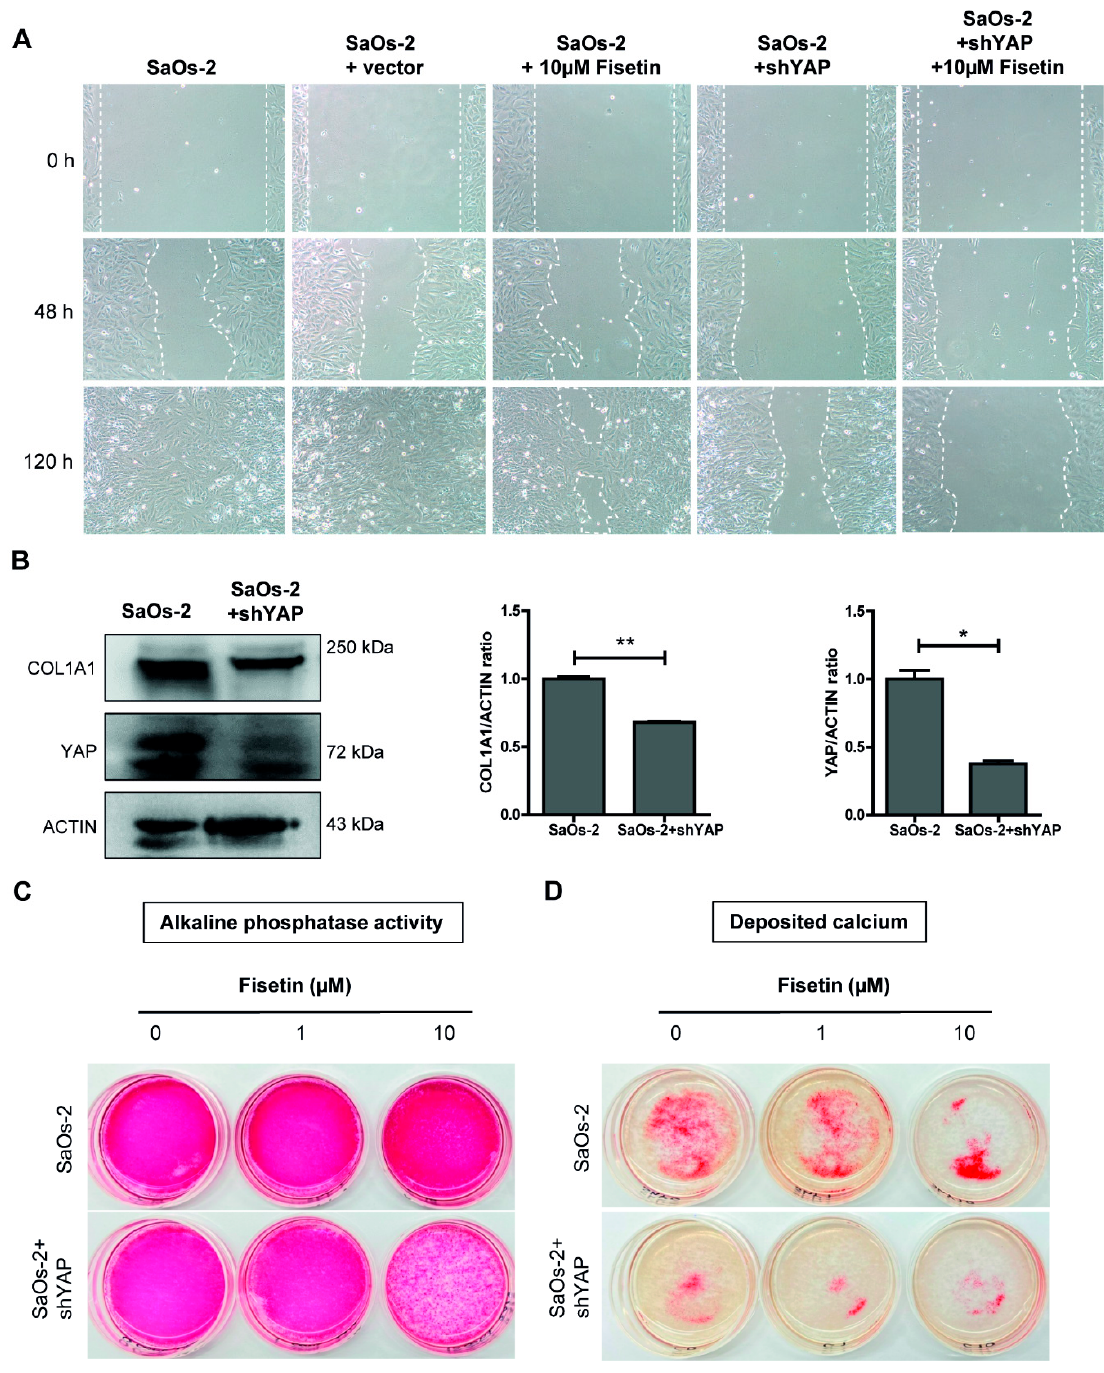
Figure 5. Targeting YAP recapitulates fisetin treatment phenotype. Control SaOs-2 cells and SaOs-2-YAP-KD cells were treated with fisetin during wound healing assay ( A ). Expression of COL1A1 and YAP, and the ratio of COL1A1 and YAP to ACTIN in SaOs-2 and SaOs-2+shYAP cells at 14 days after culturing in osteogenic differentiation medium ( B ). SaOs-2 and SaOs-2+shYAP were cultured in osteogenic differentiation medium with or without fisetin and subjected to alkaline phosphatase staining ( C ) and mineralization assay ( D ). The data presented in subfigure ( B ) were analyzed by Mann–Whitney U test. Bars indicate mean values ± standard deviation (SD) and asterisks indicate significant differences, * p < 0.05; ** p <